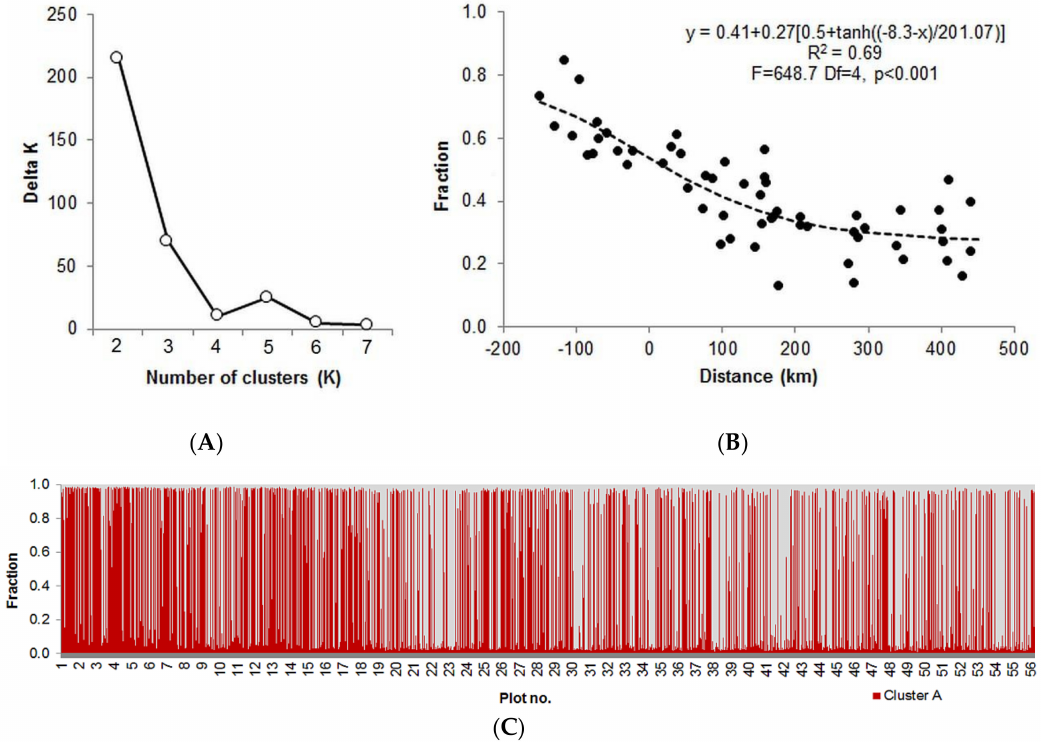
Figure 3. Values of the Delta K criterion used in the detection of the optimal number of genetic clusters by the Bayesian analysis implemented in STRUCTURE software ( A ), relationship between the frequency of the genetic group A distinguished by the Bayesian analysis in the study subpopulations and distance from the contact zone ( B ) and genetic structure of Abies alba subpopulations revealed for the two genetic groups, K = 2 ( C ). The Delta K parameter was calculated according to an algorithm by Evanno et al. [57]. The negative / positive values in Figure 3B indicate distances in the eastern / western direction from the contact